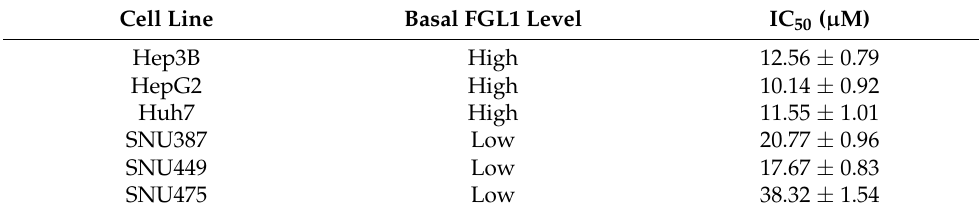
Table 1. IC 50 of sorafenib against HCC cell